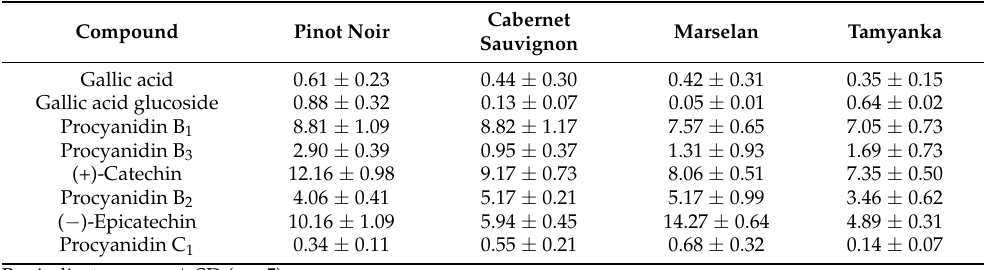
Table 3. HPLC determination of phenolic compounds in grape seed extracts (mg/g DW). Compound Pinot Noir